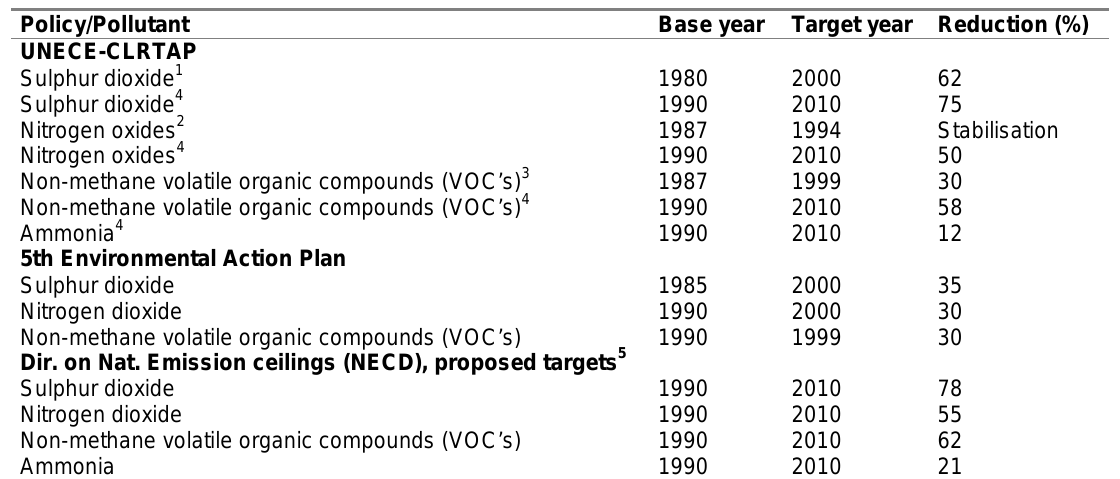
Air Emission Reduction Targets for the